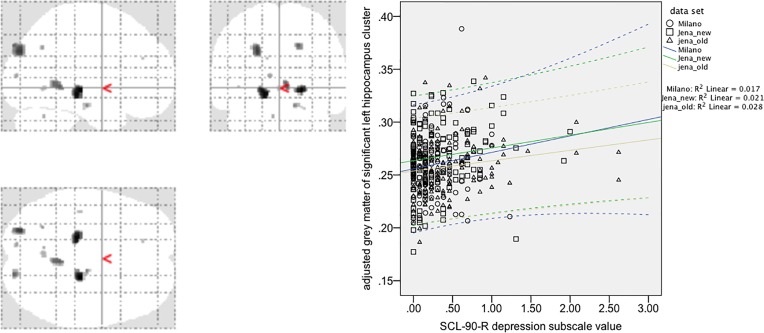
Voxel-based morphometry analysis of positive correlations between gray matter values (GMV) and SCL-90-R depression subscale value in 409 healthy controls (exploratory post hoc analysis, p < 0.001, uncorrected). Note that the region-of-interest (ROI)/small-volume correction-based analysis for the left hippocampus cluster (maximum coordinate 20; −28; 8; Z score 3.59) survived correction for multiple comparisons (p = 0.010, FWE corrected at peak level, p = 0.042, FWE corrected at cluster level). A correlation plot for the most significant voxel of this left hippocampus cluster [small volume correction (SVC) corrected analysis] is given in the right side of the figure. Spearman´s Rho for the correlation is 0.12 (p = 0.015, two-tailed significance at p = 0.05), CI 0.024–0.216.